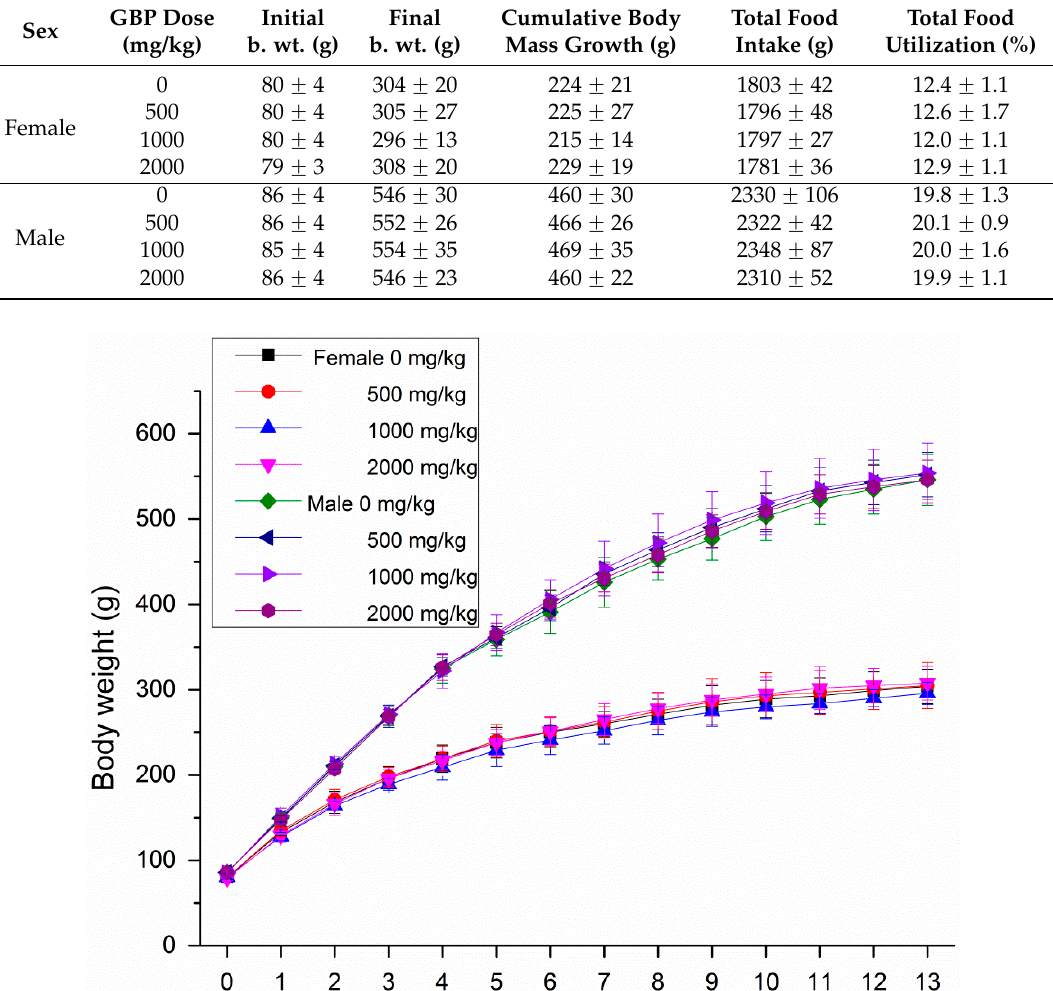
Table 5. Effects of GBP on body weight, food intake and food utilization rate after rats were treated for 91 days (x ± s, n = 10).